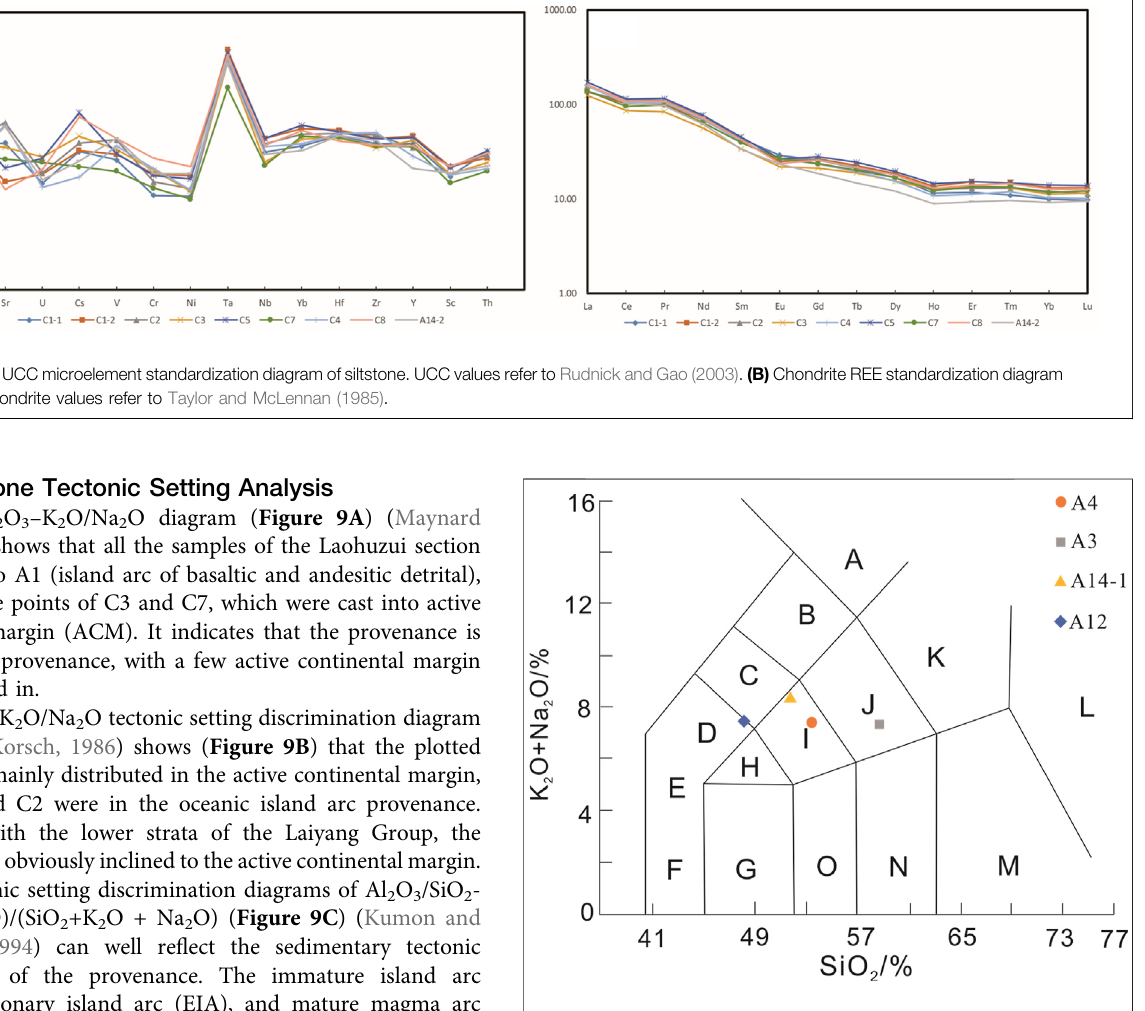
FIGURE 6 | TSA diagram of igneous rock samples, after Bas et al. (1986). (A-phonolite, B-tephriphonolite, C-phonotephrite, E-tephrite, F-picrobasalt, G-basalt, H-trachybasalt, I-basaltic trachyandesite J-trachyandesite, K-trachyte, L-rhyolite, M-dacite, N-andesite, and O-basaltic